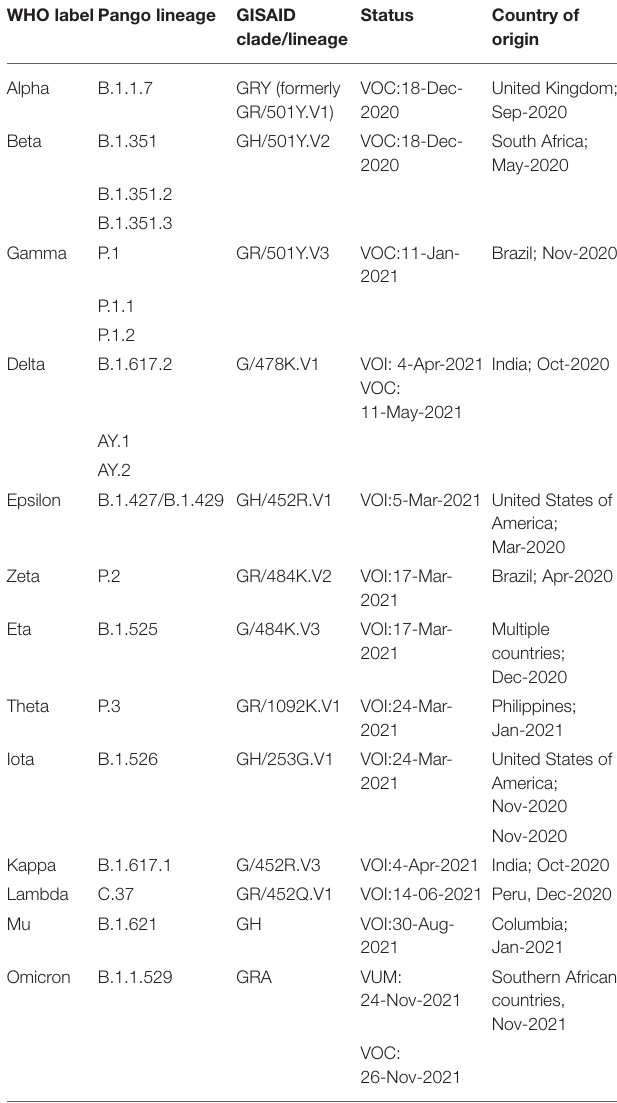
TABLE 1 | Summary of VOI and VOC as published by WHO (https://www.who. int/en/activities/tracking-SARS-CoV-2-variants, Last accessed on 17 Dec, 2021). WHO label Pango lineage GISAID clade/lineage